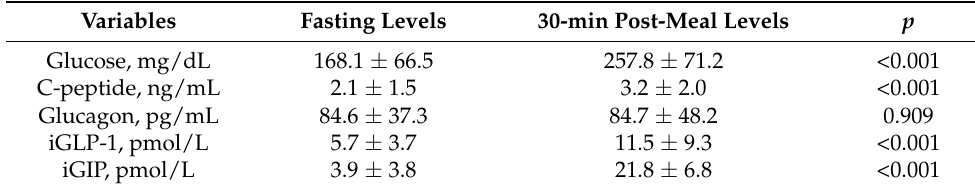
Table 2. Blood levels of glucose, C-peptide, glucagon, and intact incretin before and 30 min after ingestion of a standard mixed meal ( n = 317).